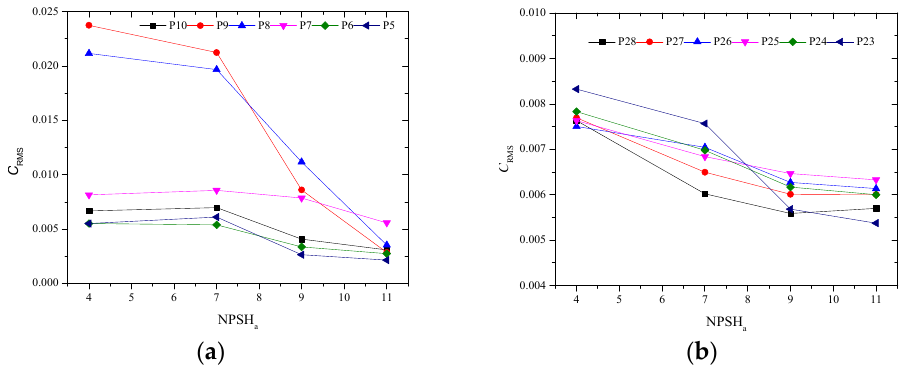
Figure 13. Low-frequency pulsation intensity of the impellers at all levels under different cavitation conditions. ( a ) Primary impeller and ( b ) secondary impeller.